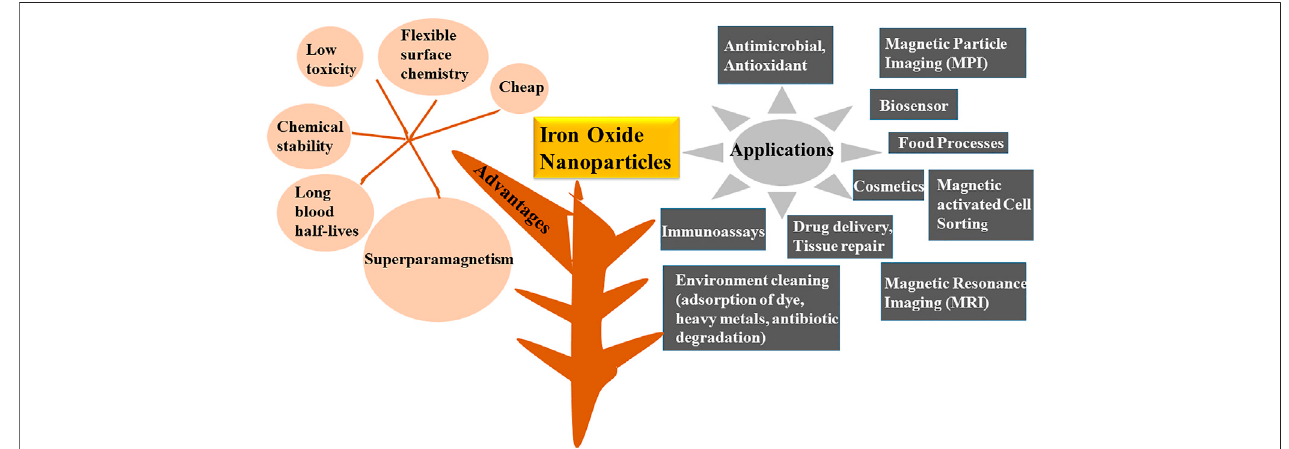
FIGURE 1 | Advantages and applications of Iron oxide nanoparticles.